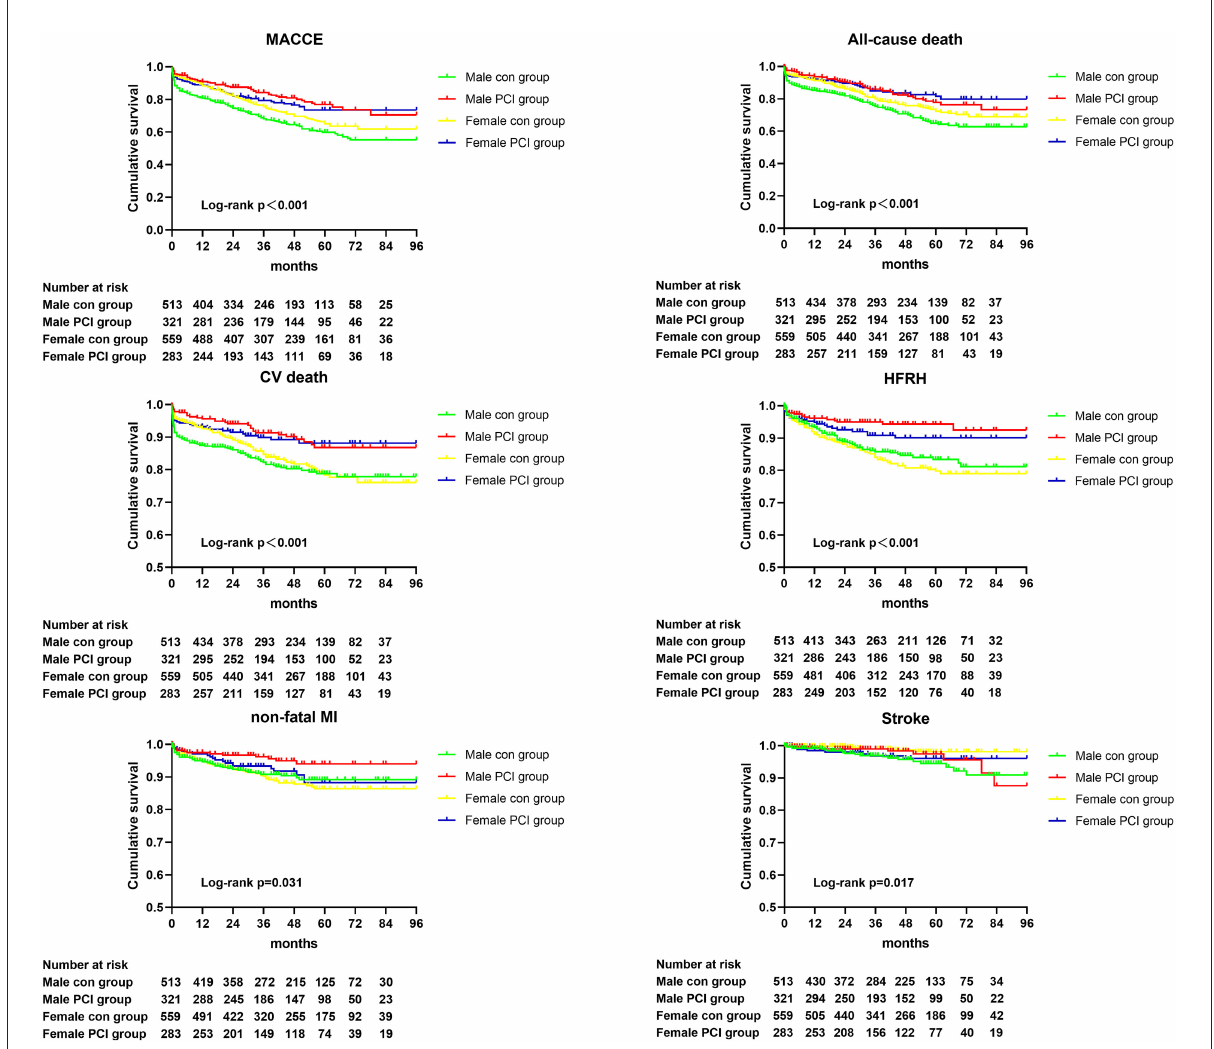
FIGURE4 Kaplan–Meier curve analyses for primary and secondary endpoints in PCI and conservative management group by gender. MACCE, major adverse cardiovascular and cerebrovascular events; CV, cardiovascular; HFRH, heart failure requiring hospitalization; MI, myocardial infarction; PCI, percutaneous coronary intervention; con, conservative